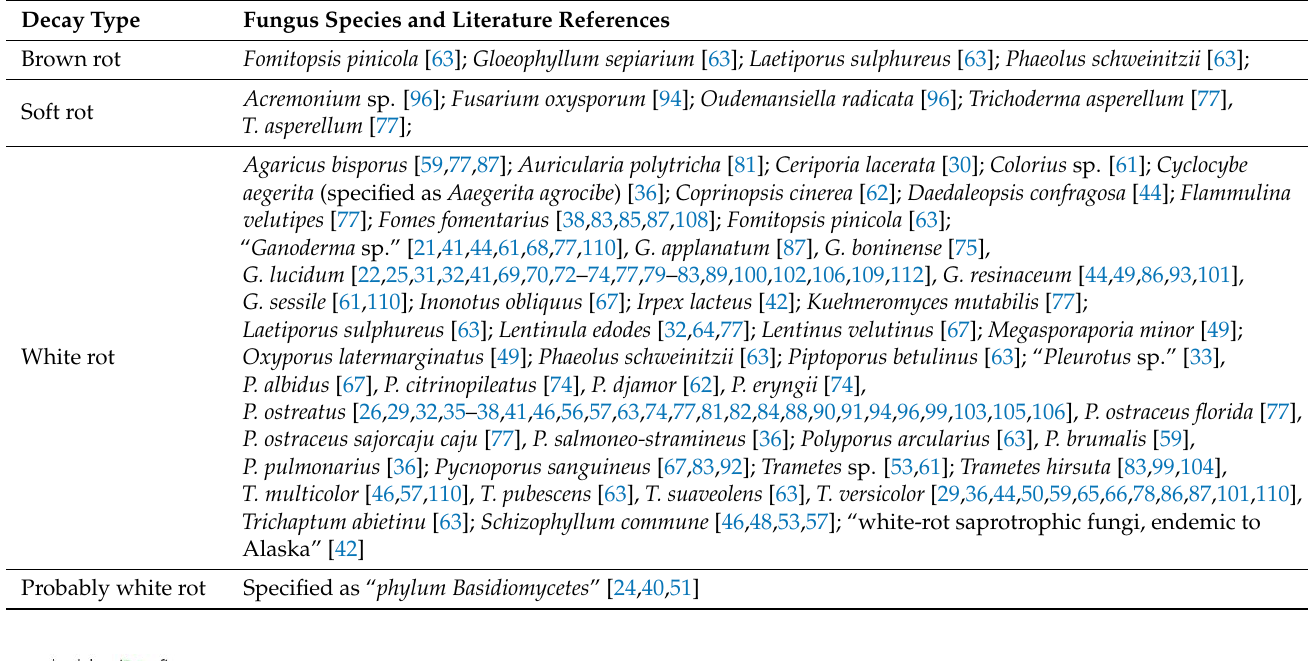
Table 1. Fungus species in scientific publications related to Mycelium-Based Composites.